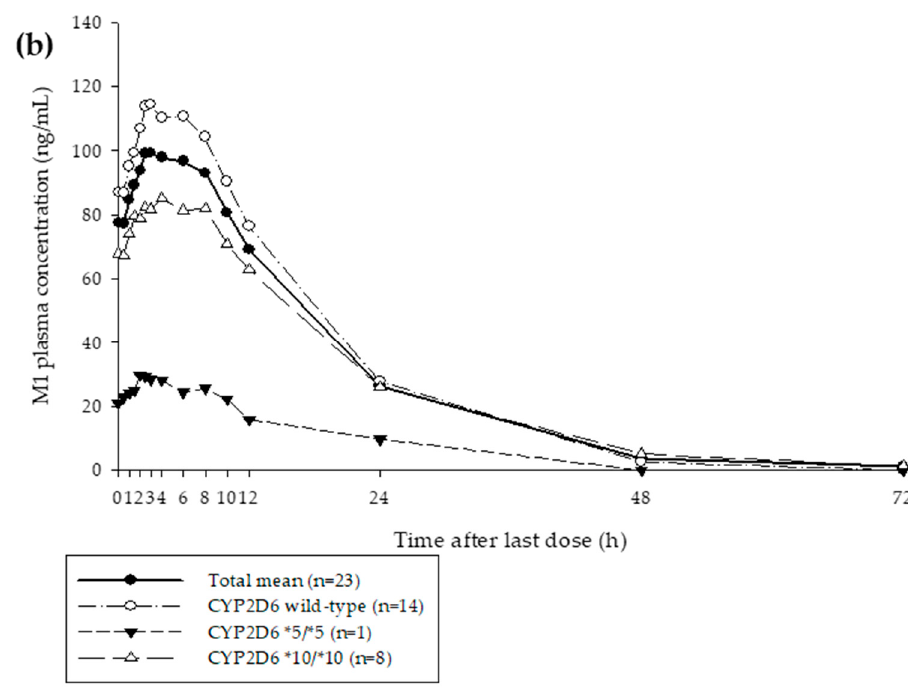
Figure 1. The average plasma concentration–time profiles after five times oral administration ( τ = 12 h) of 100 mg tramadol for ( a ) tramadol and ( b ) O -desmethyltramadol (M1). Solid blue line, average for all subjects ( n = 23); solid black line, CYP2D6 wild-type subjects ( n = 14); short dashed black line, CYP2D6 *5/*5 subject ( n = 1); long dashed black line, CYP2D6 *10/*10 ( n = 8).